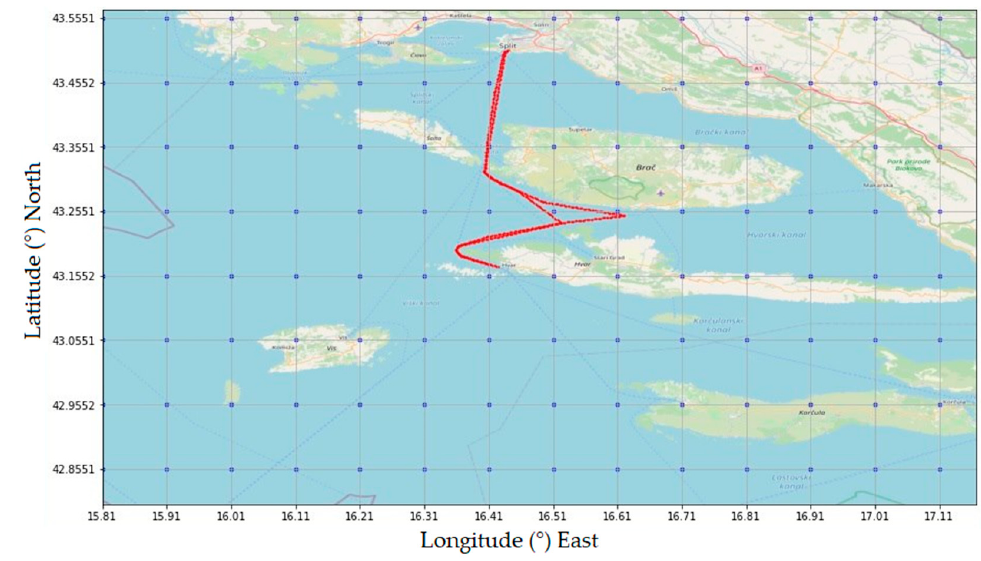
Figure 10. Generated ship and its route from